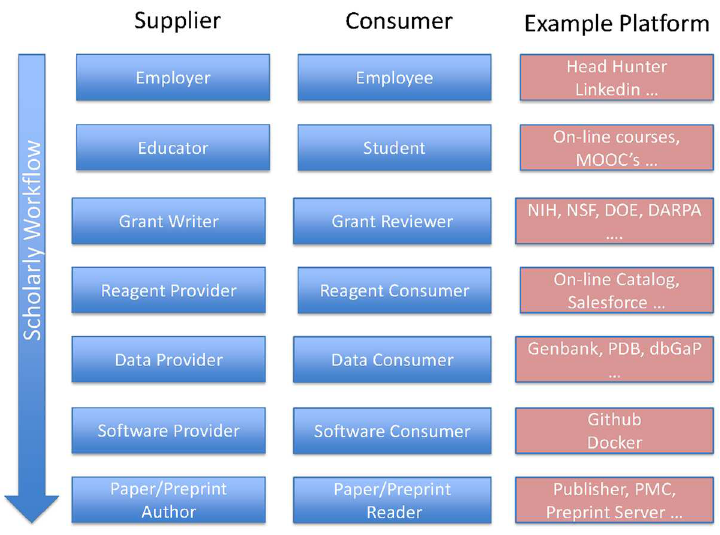
Fig 1. Discretesuppliers and consumers and associated platforms supporting the scholarly workflow. While presented as a linear path for simplicity, in reality, it is more a network of interactions.